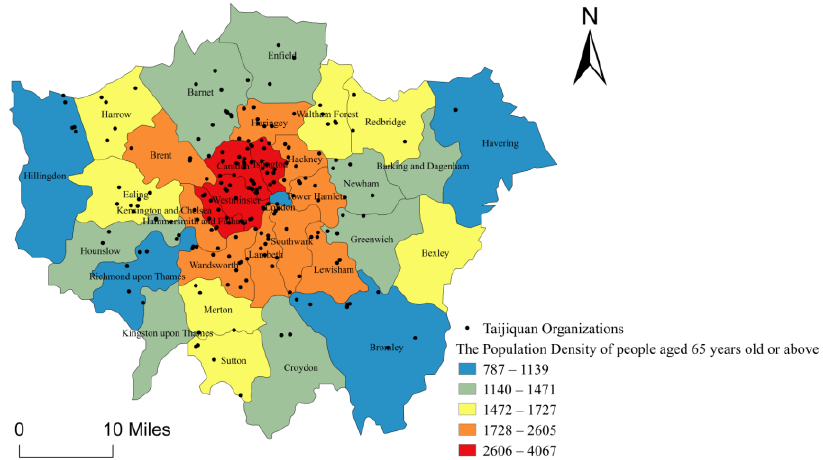
Figure 8. Population Density Map of People Aged 65 Years Old or Above in